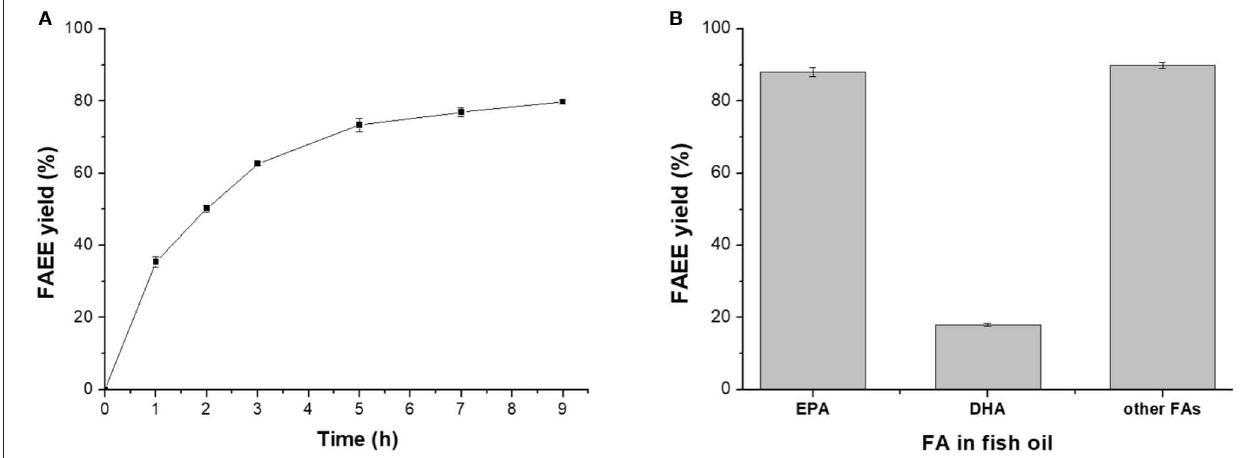
FIGURE 4 | Lipase-mediated ethanolysis of fish oil under optimized conditions. (A) Effect of time. (B) Conversion of different FAs to their esters.